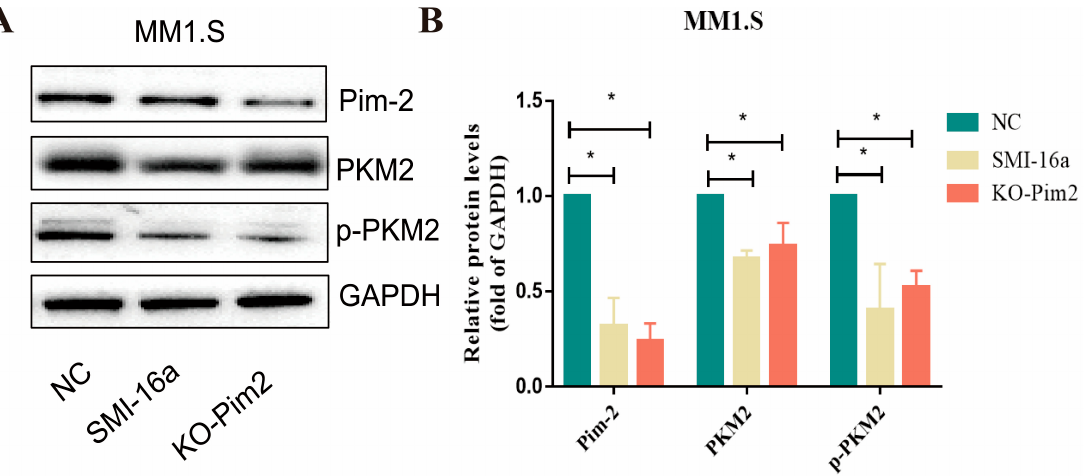
Figure 5. Pim-2 kinase inhibitors decrease PKM2 expression and phosphorylation. ( A ). Western blot analysis showed that the expression of p-PKM2 and PKM2 was downregulated. ( B ). The histogram of quantitative analysis of PKM2, p-PKM2, and Pim-2 (based on fold change of glyceraldehyde-3- phosphate dehydrogenase [GAPDH]). * Indicates a significant difference compared with the HC group, p <